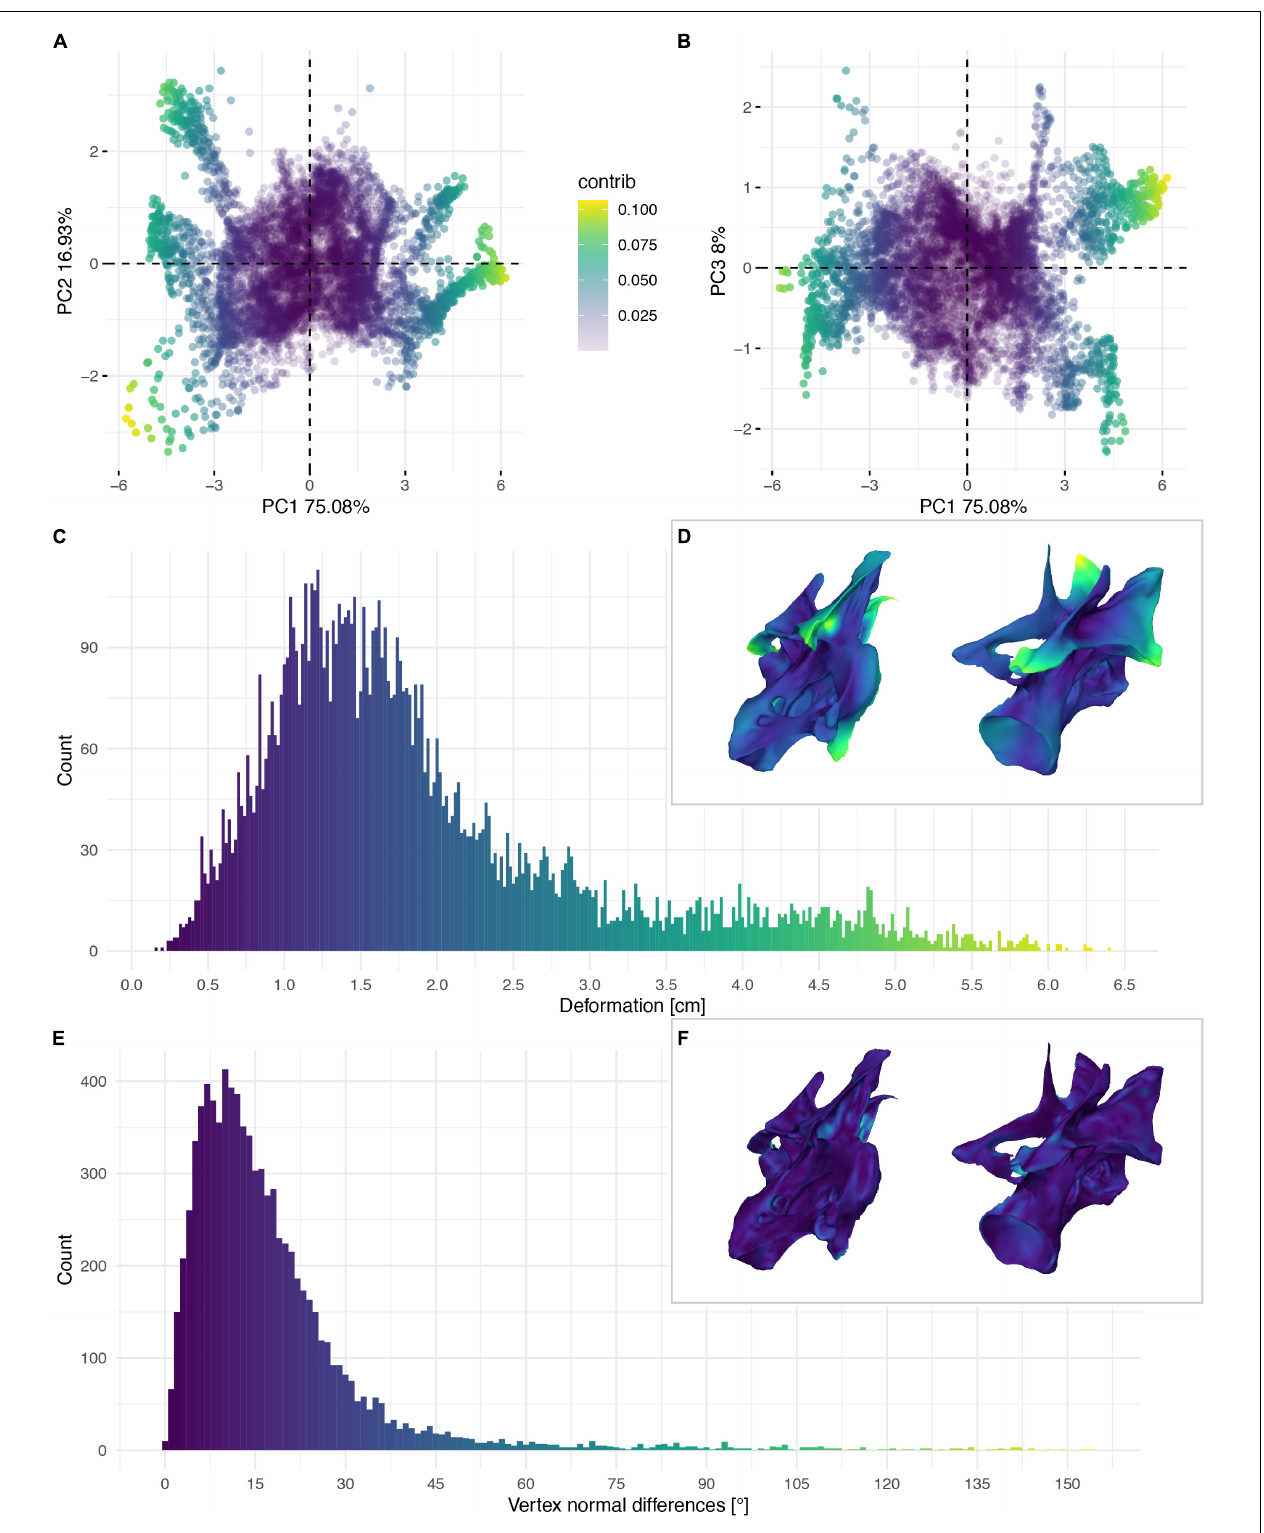
FIGURE 9 | Deformation of CV 10 of Galeamopus pabsti SMA 0011/NMZ 1000011. PCA of the differences in the components of the vector between corresponding vertices (A,B) . PC1 represents the major axis of deformation. Histograms of the absolute deformation (morphological distance) between the trimmed reconstruction and the exposed original specimen (C) and the angles between the different orientations of the corresponding vertex normals (E) . Visualisation of the deformations in oblique views (D,F) .